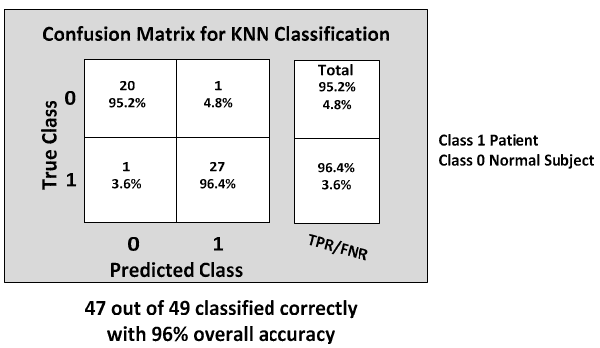
Figure 18. The final Confusion matrix showing the gait classification results using the KNN classification model with the TPR and False Positive Rate (FPR).